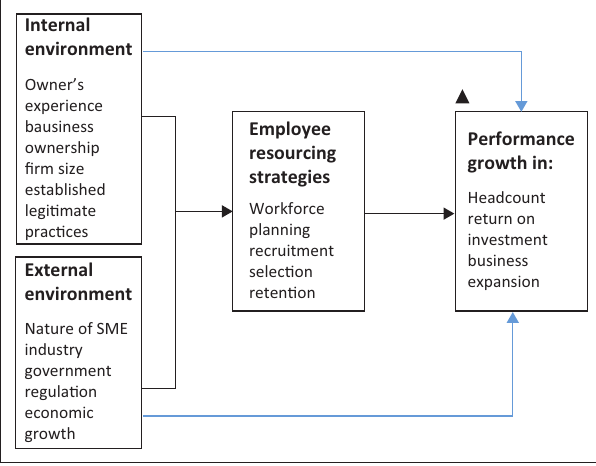
FIG URE 1: Conceptual